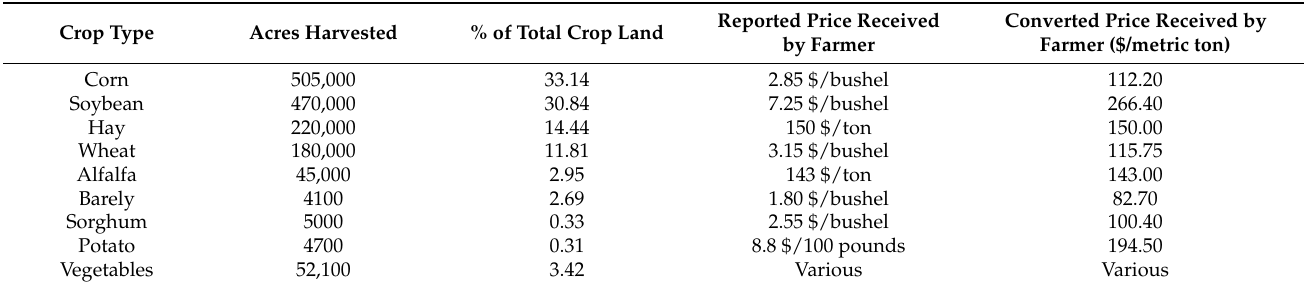
Table A2. Itemized cost estimates for irrigation systems. These values represent the average seasonal price received by Maryland farmers in 2003, as reported by the Maryland Agricultural Statistics Services (MASS).